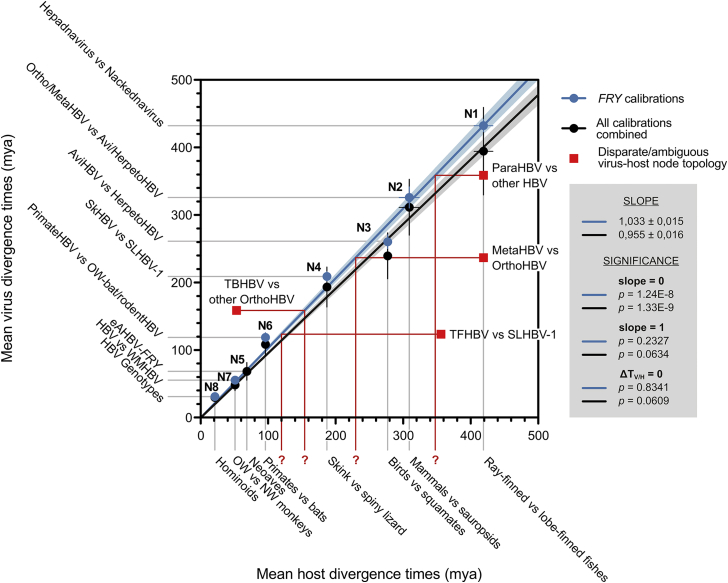
Correlation of Mean Divergence Times between Hepadnaviruses and Their HostsFor the nodes in the hepadnaviral phylogeny representing putative virus-host cospeciation events (Figures 5 and S6A), the mean virus divergence times obtained with the calibrations based on eAHBV-FRY (blue) and the 11 independent calibrations based on the branching of exogenous hepadnaviruses in addition (black), were plotted against the mean host divergence times as retrieved from the literature (The Timetree of Life, 2016, Betancur et al., 2013, Bininda-Emonds et al., 2007, Hedges et al., 2015, Wang et al., 2013) (raw data in Table S2). Vertical and horizontal bars: SD. The nodes (N1–N8) are numbered as in Figures 5 and S6B. The linear regression of the eAHBV-FRY-calibrated nodes indicates a tight congruence between the related virus and host speciation times (blue line; 95% confidence interval: light blue background). Of note, the mean age estimate for the node of eAHBV-FRY resulting from the control calibrations (N5; 67.9 ± 13.6 mya SD) was consistent with the onset of the diversification of Neoaves (69–67 mya), implying that the long-term substitution rate of P proteins does not significantly differ between exogenous and endogenous hepadnaviruses. Both linear regressions had a significant deviation of the slope from 0, a non-significant deviation of the slope from 1, and the differences between the related virus and host divergence times (ΔTV/H) did not significantly differ from 0 (box with gray background). Red squares: the eAHBV-FRY-based node age estimates for the major viral nodes with disparate or ambiguous virus-host topology (Figures 5 and S6A) were plotted against the divergence times of the corresponding present-day hosts. The significant deviation of these nodes from the linear correlation of such nodes with congruent virus-host topology indicates a host switch to have occurred. The red lines and question marks indicate the expected age of the putative initial host reservoir, if these viruses also originated from a virus-host cospeciation event before they switched into a new host. For example parahepadnaviruses, i.e., WSHBV and CSKV, split off from all other hepadnaviruses 359 mya, i.e., at about the same time, when amphibians and amniotes diverged (352 mya according to http://timetree.org/). Likewise, TBHBV, so far the only known hepadnavirus from a South American bat (Drexler et al., 2013), separated from the other orthohepadnaviruses 158 mya, i.e., at about the same time, when placental and marsupial mammals diverged (159 mya according to http://timetree.org/). These observations might at least give a clue where to search for similar viruses.